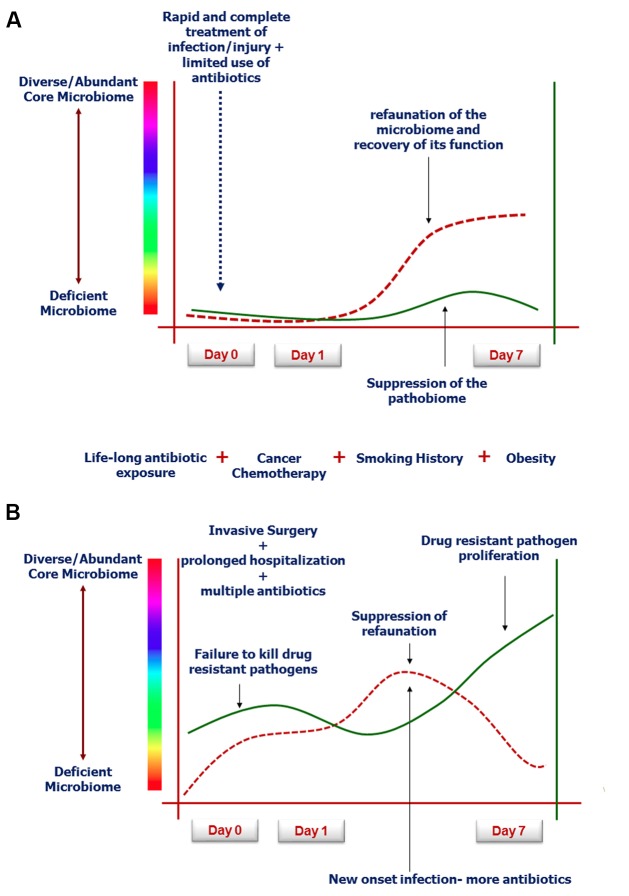
Rate and degree of microbiota refaunation on recovery from severe catabolic stress such as following human critical illness (Guyton and Alverdy, 2016; Krezalek and Alverdy, 2016; Alverdy and Krezalek, 2017). (A) Demonstrates typical response to successful modern medical care with limited antibiotic exposure and rapid resolution of the infection or injury (Modi et al., 2014). (B) Represents the aging patient population with multiple exposures to western diet, smoking etc, who have fragile microbiomes that cannot recover when invasive surgery and toxic agents are used to treat complex disorders such as cancer (Shogan et al., 2014; Shakhsheer et al., 2016).